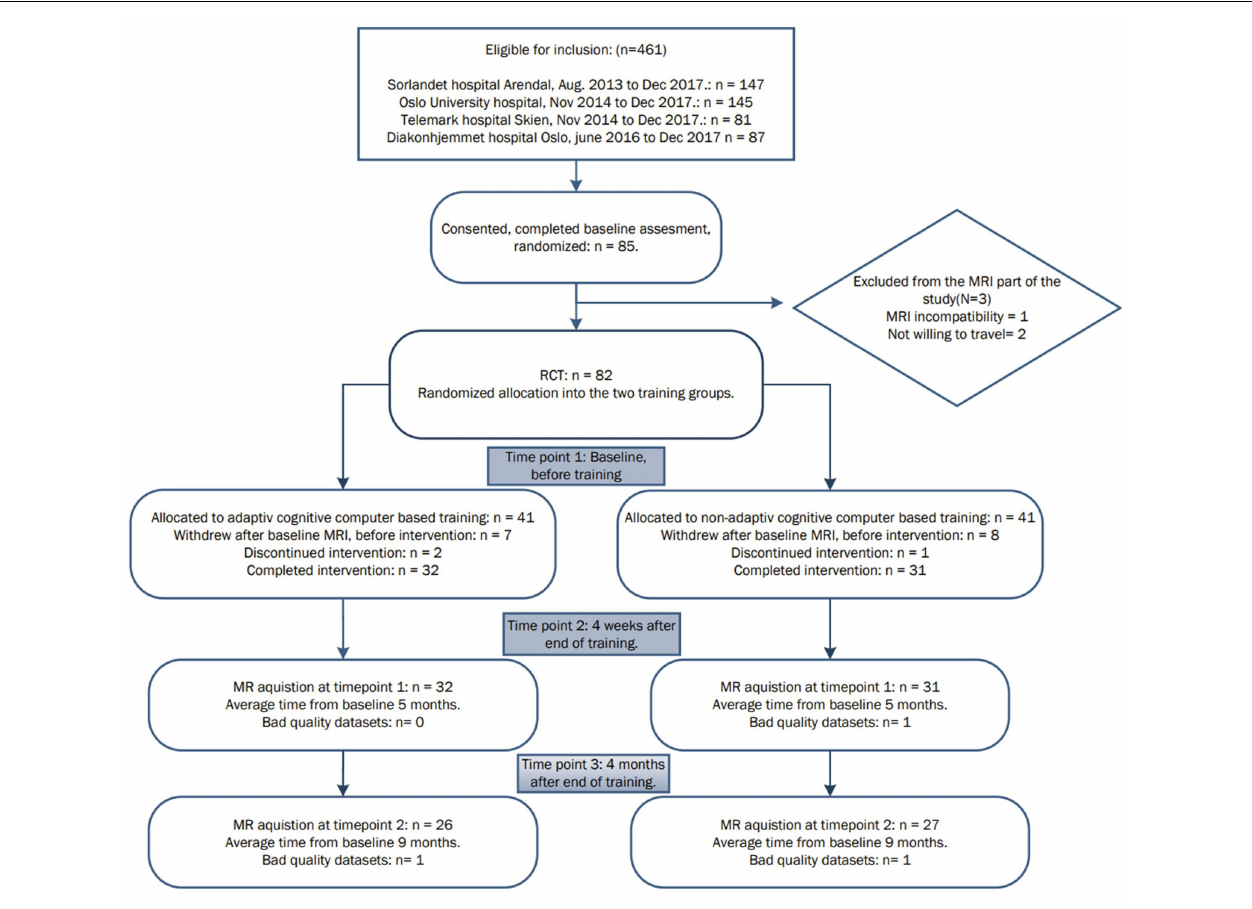
FIGURE 1 | Overview of the patient inclusion process and visits during the